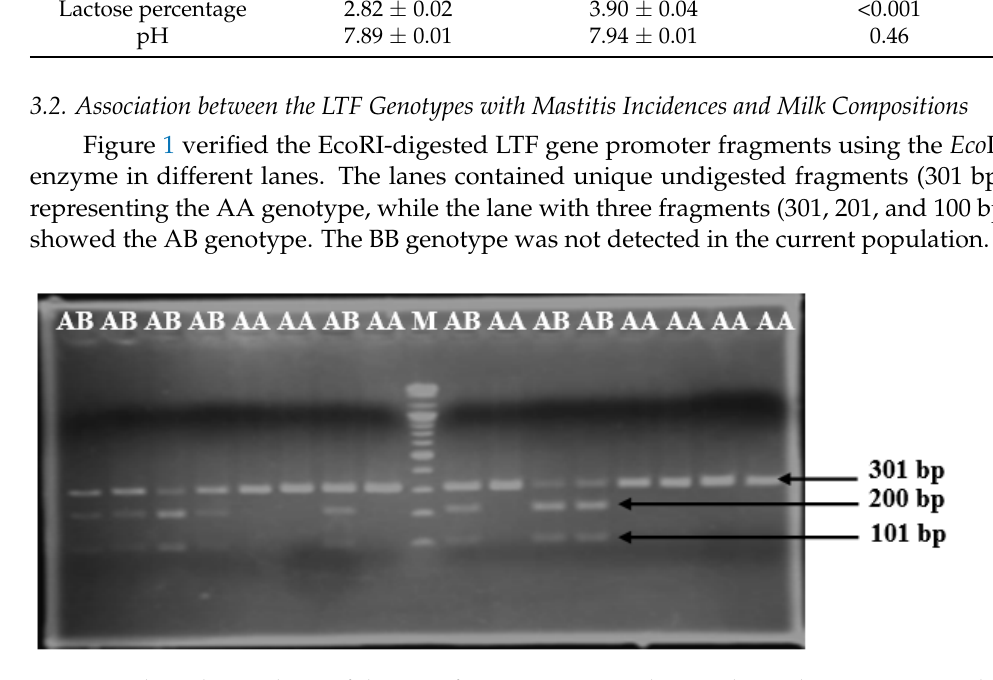
Figure 1. The polymorphism of the Lactoferrin gene. AB and AA indicate the genotypes, and M indicates the leader. Bp: base pairs.